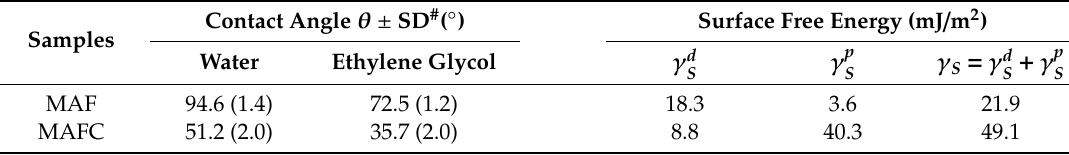
Table 3. Contact angles and surface free energy of MAF and MAFC.